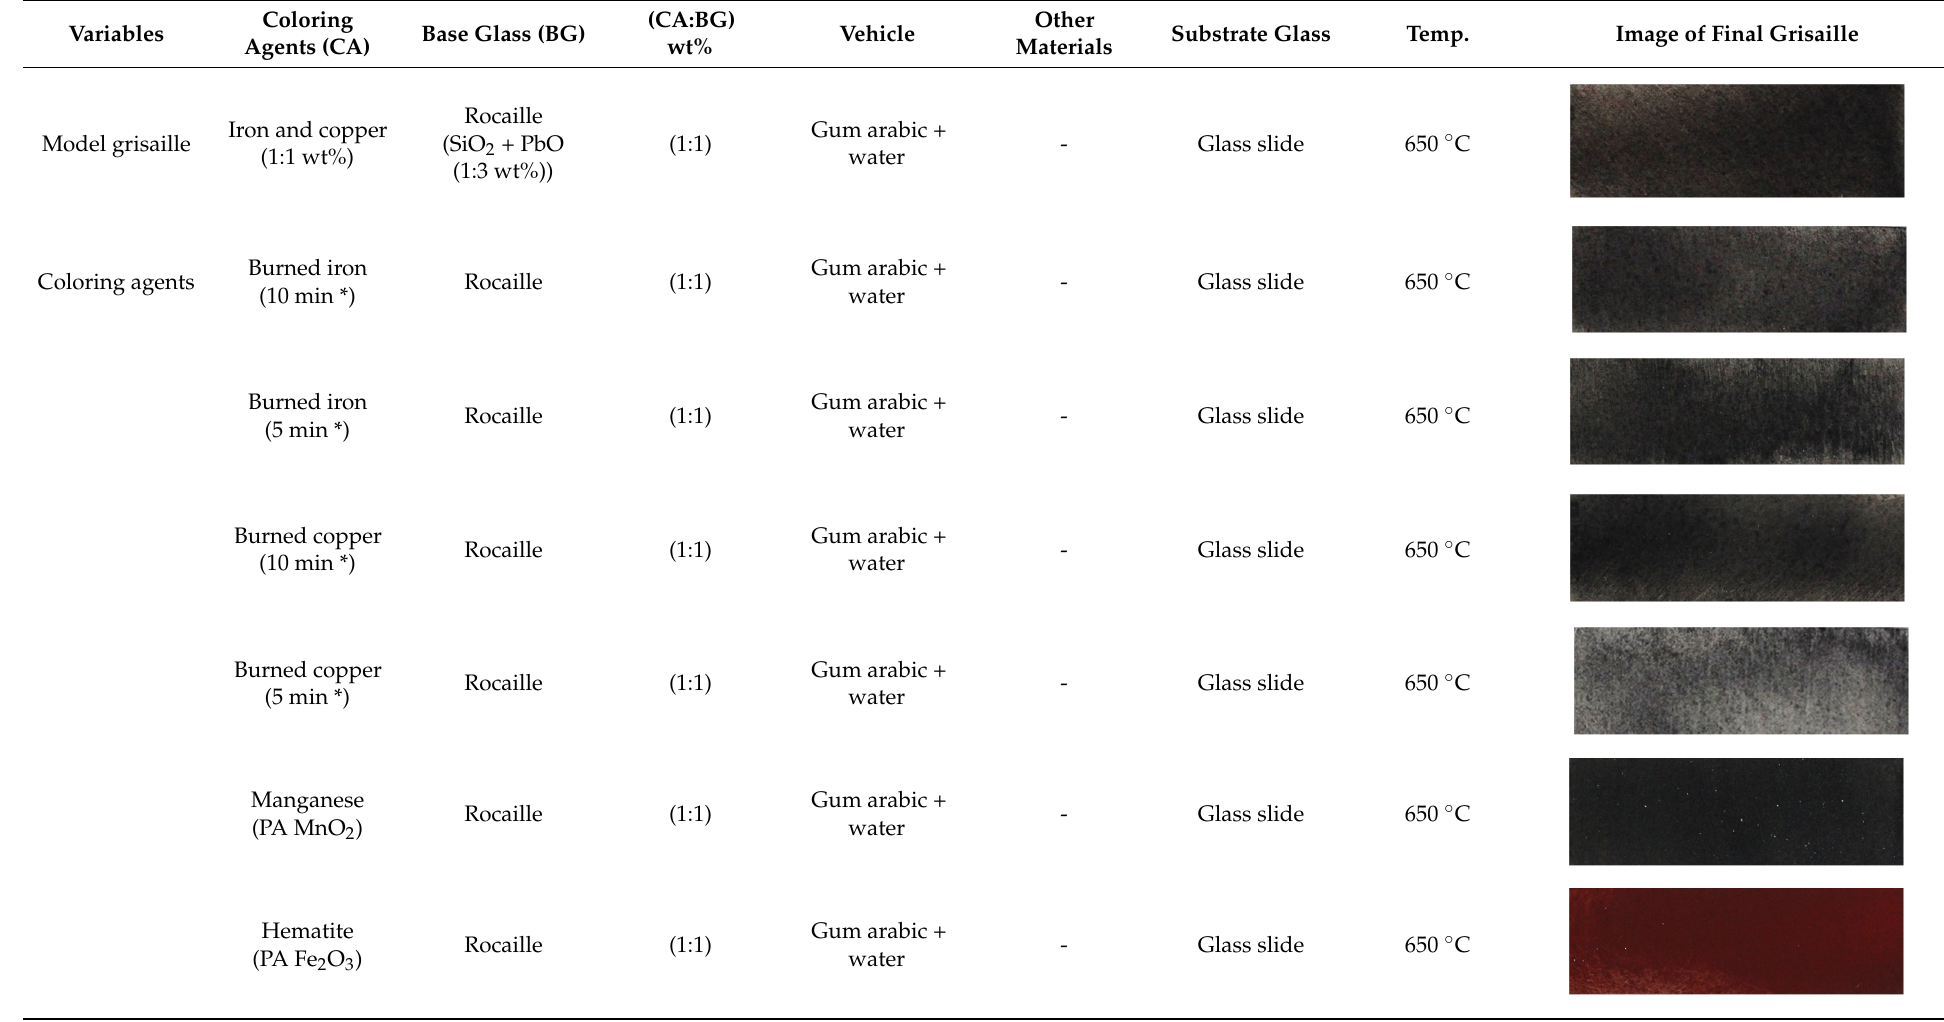
Table 1. Produced grisailles formulation and image of the final grisaille for each formulation. (* grinding time, PA: practical grade).